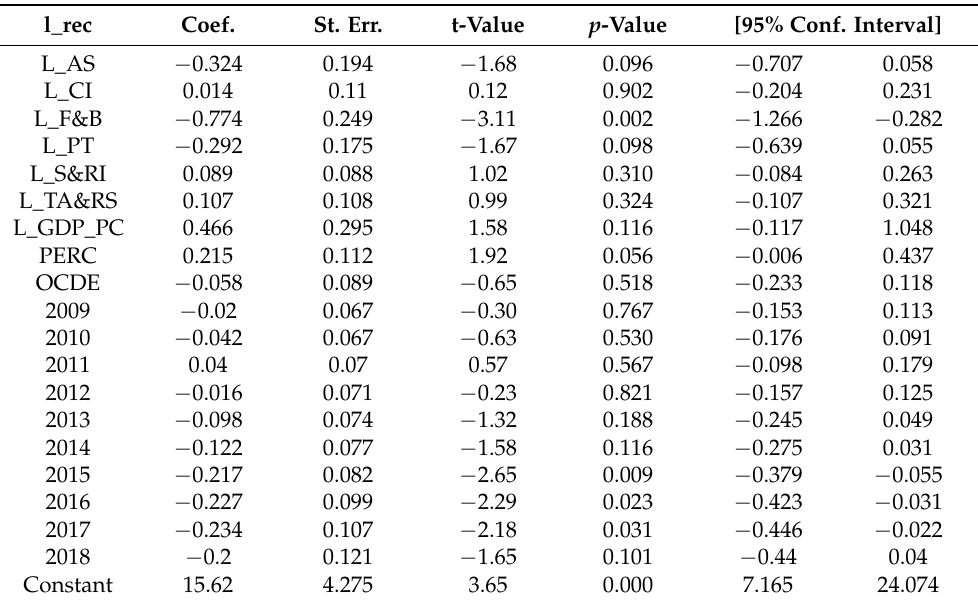
Table A7. Panel data estimations of the explanatory variables of tourism receipts (in logarithm) for the countries in the sample. Fixed effects panel with temporary